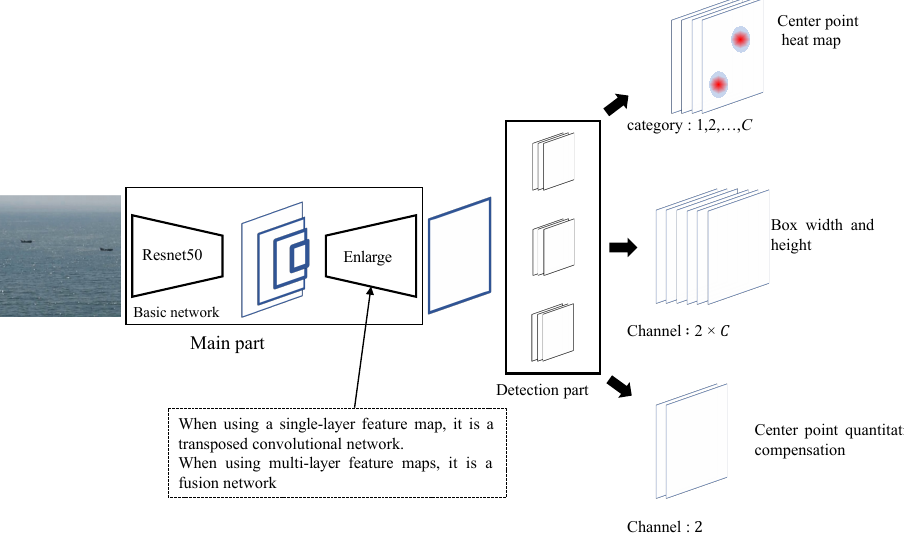
Figure 3. CenterNet algorithm diagram. Note that C denotes the number of channels of the feature map.